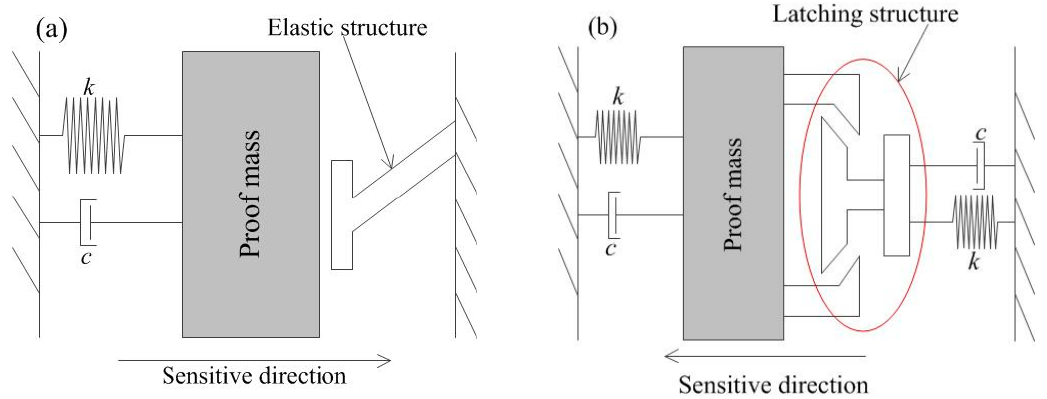
Figure 1. ( a ) The operating principle of flexible contact and ( b ) the principle of latching structure.